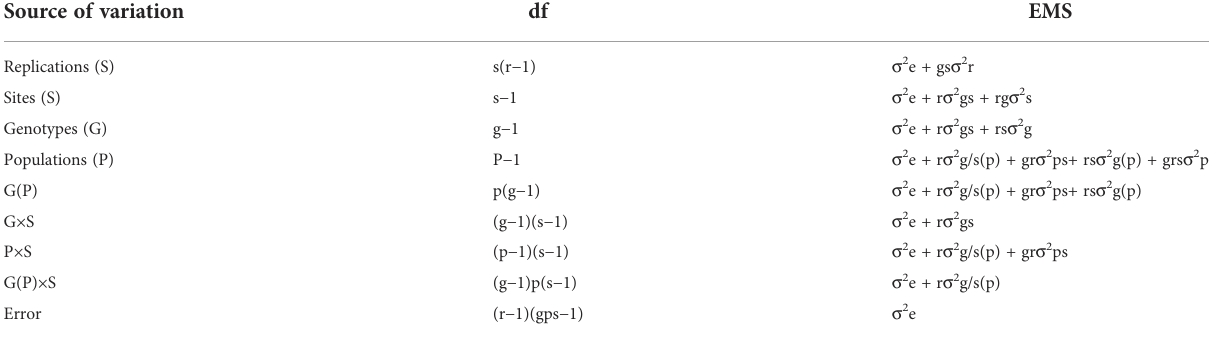
TABLE 3 ANOVA table for combined sites and